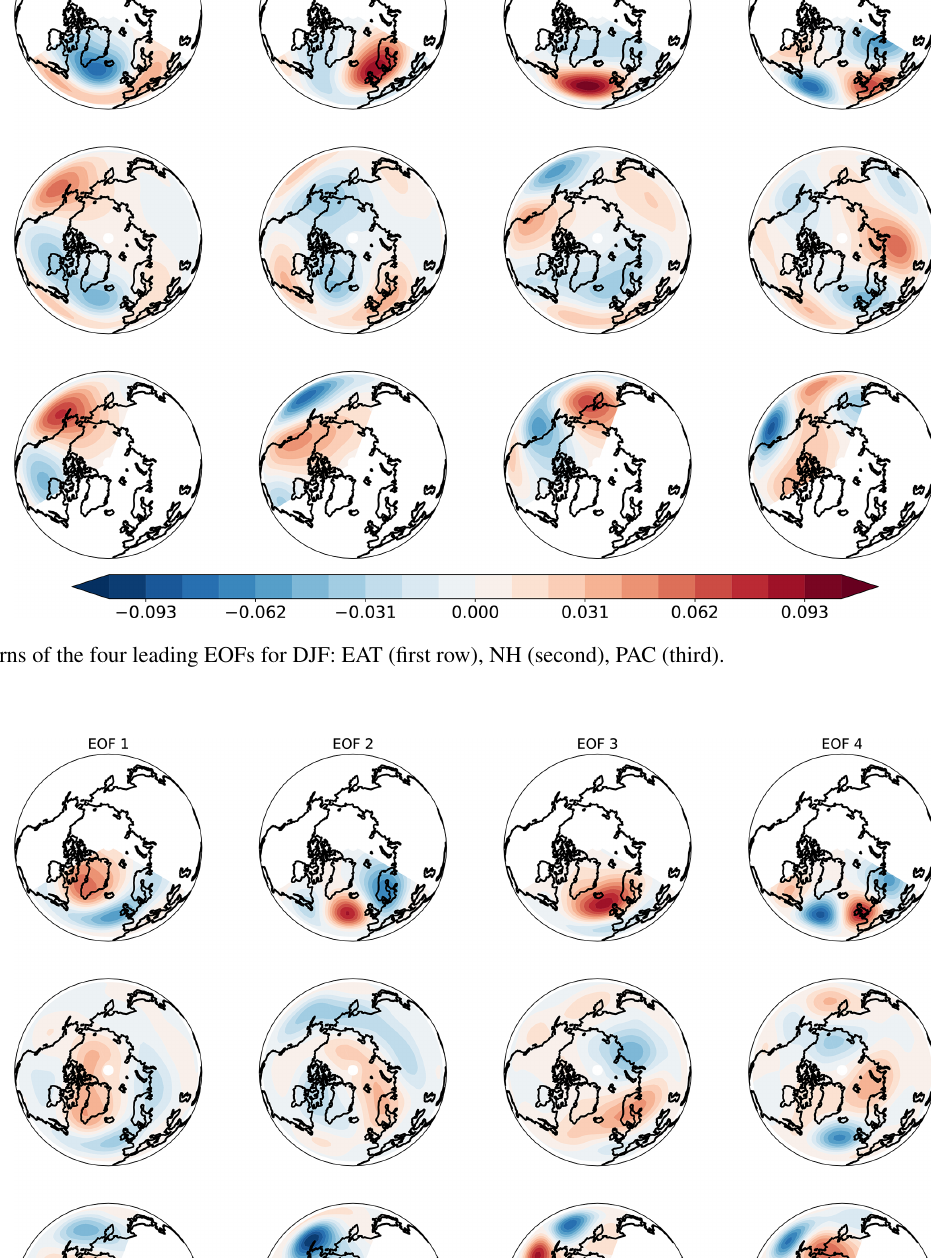
Weather Clim. Dynam., 3, 1037–1062, 2022